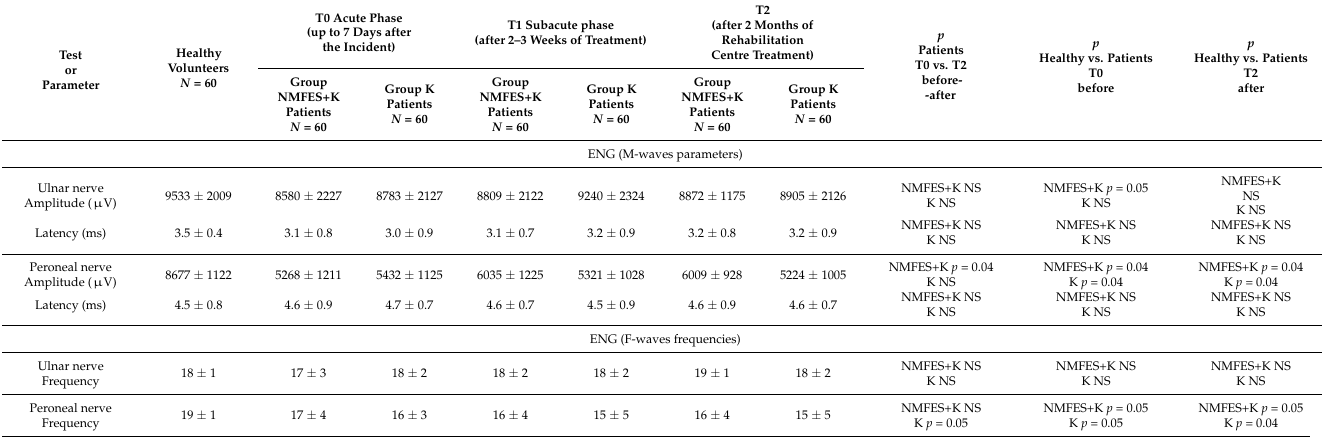
Table 3. Comparison of results from neurophysiological studies recorded in two groups of patients and healthy subjects. Results refer to measurements performed in patients on the paretic side identified in preliminary clinical